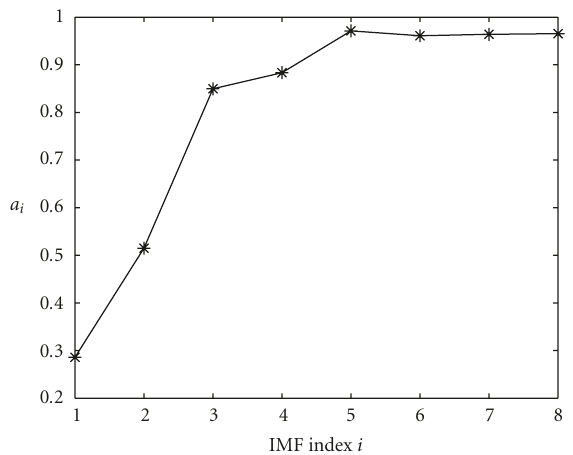
Figure 1: Optimal coe ffi cients a i ’s for the